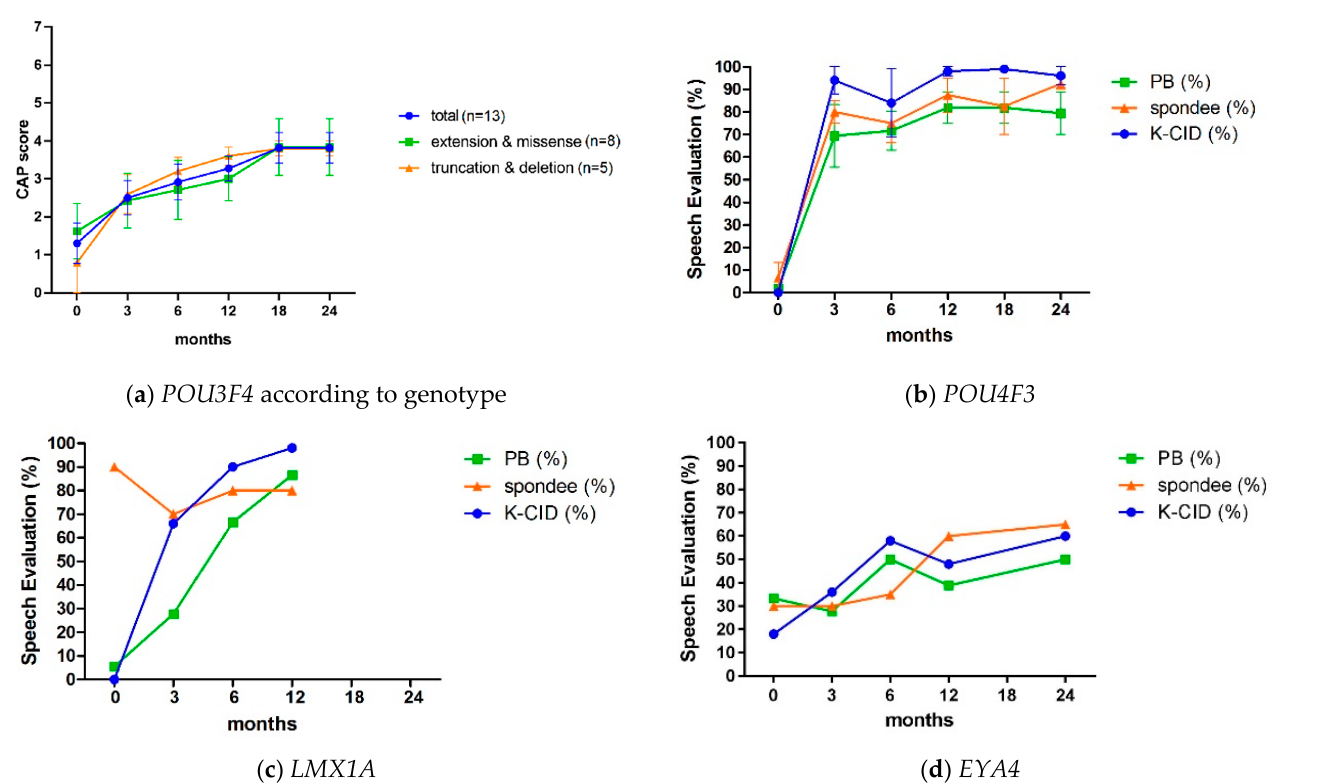
Figure 2. Postoperative cochlear implant outcomes in patients with mutations in transcription factor genes: ( a ) POU3F4 according to genotype; ( b ) POU4F3 ; ( c ) LMX1A ; ( d ) EYA4 .